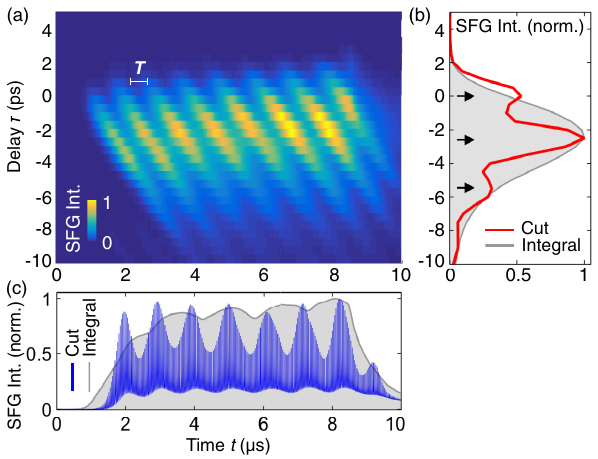
FIG. 5. Subpulse formation and limit-cycle oscillations of the FEL oscillator. Evolution of the FEL pulse shape I ð τ Þ is obtained by SFG cross-correlation at Δ L ¼ 1 . 75 λ . Cross-sections from the 2D plot (a) are along the constant time t ¼ 8 μ s (b) and the constant delay τ ¼ − 3 ps (c), respectively. The composition of the micropulse of equally spaced subpulses (i.e., multiple peaks) in (b) and the limit-cycle power oscillation within the macropulse (c) are directly resolved. The time- or delay-integrated intensity envelopes are plotted for comparison in (b) or (c), respectively (grey area). Temporal separation of the subpulses [marked by arrows in (b)] is 2.7 ps. The amplitude modulation of the individual micropulses is clearly visible in (c).